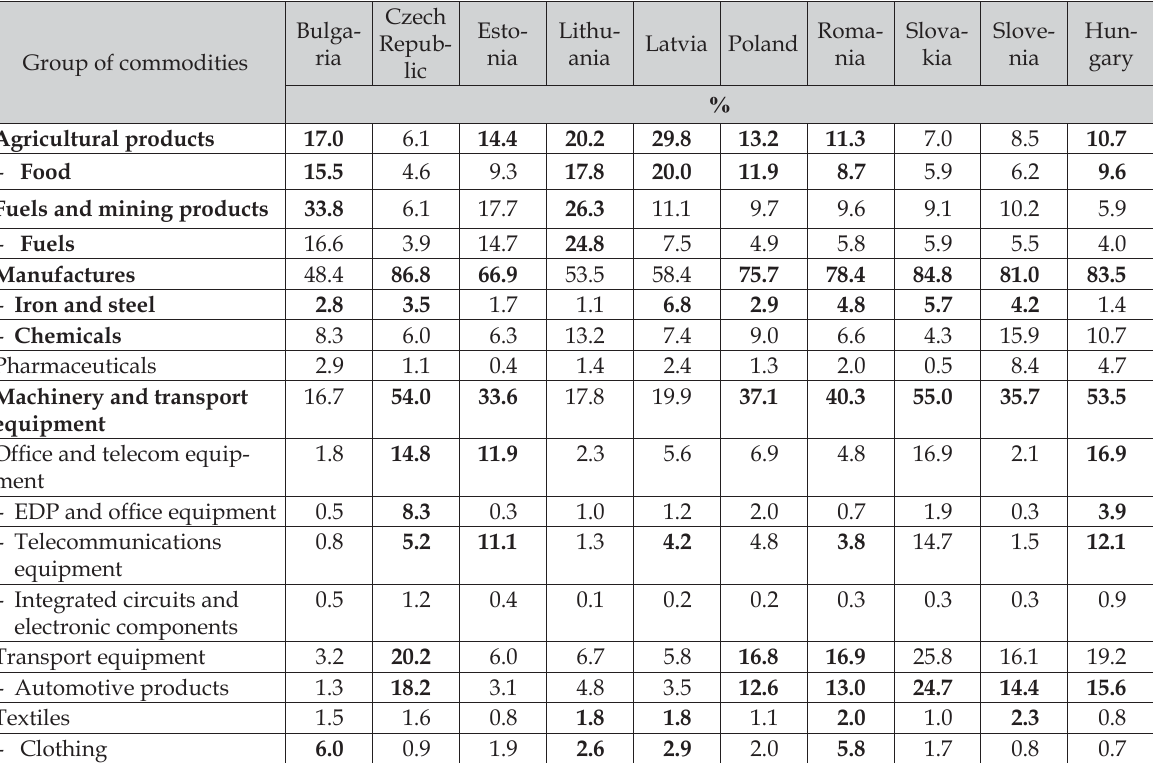
Table 4. The structure of exports in the post-communist countries in 2012.